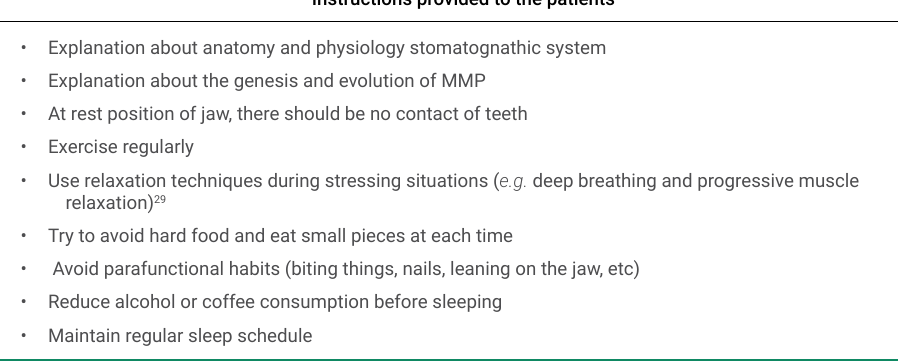
Table 1. Counseling and self-care strategies given to the